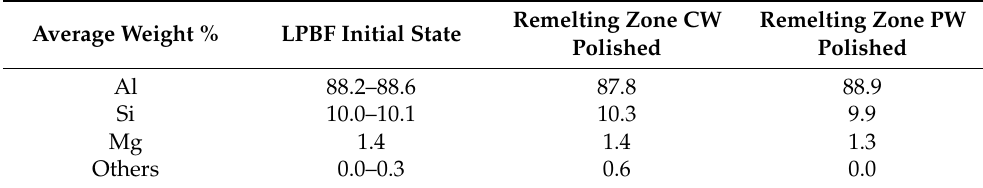
Table 6. Chemical composition of the remelting zone in comparison to the LPBF-initial state, measured by